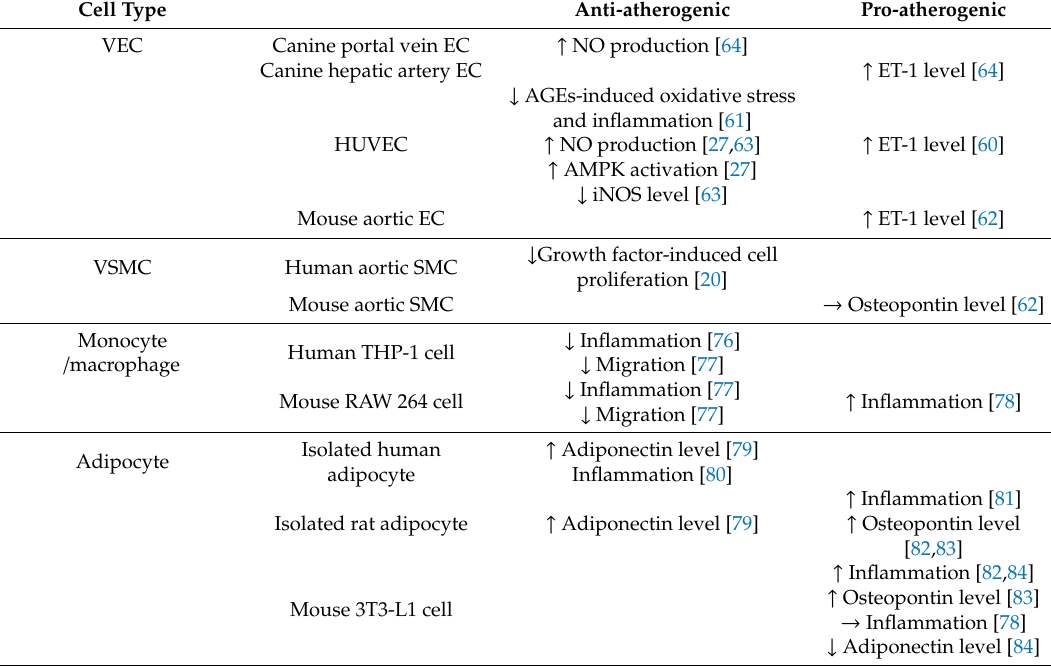
Table 1. E ff ects of glucose-dependent insulinotropic polypeptide (GIP) on cultured cells related to cardiovascular disease. ↑ , increase; → , no change; ↓